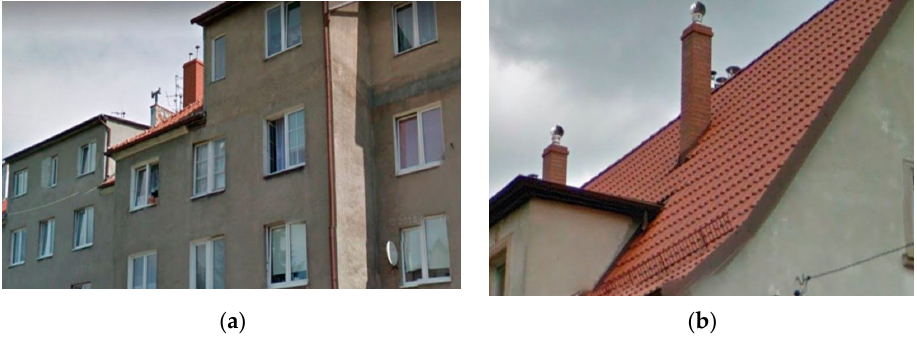
Figure 21. Multi-family housing in Gda ń sk: ( a ) traditional chimney cap and ( b ) rotary type chimney cap.